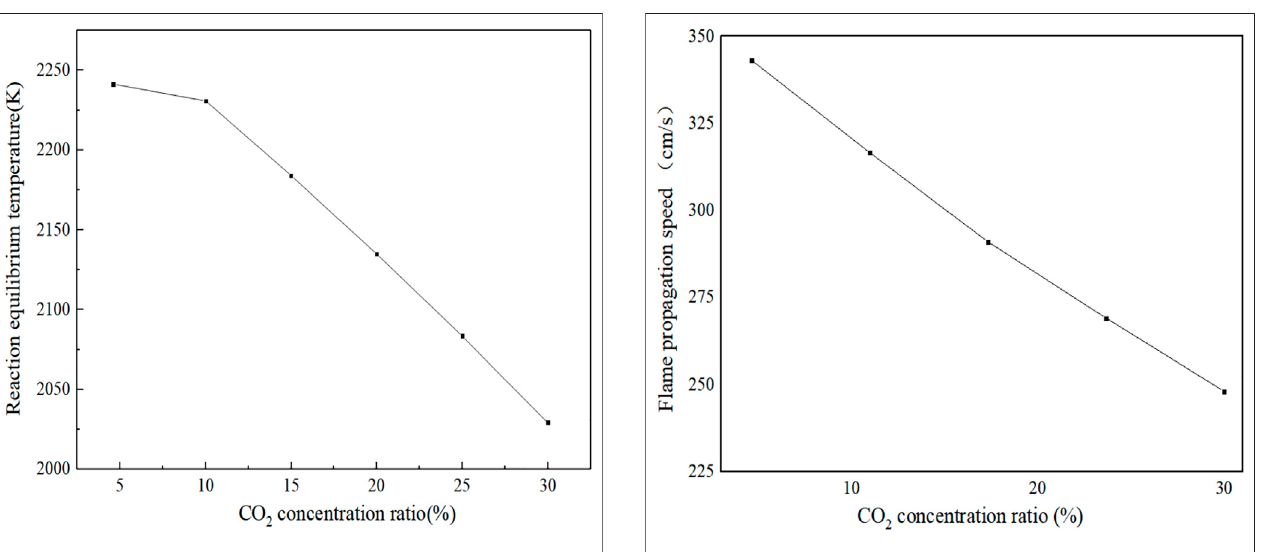
FIGURE 13 | Variation of fl ame propagation speed with CO 2